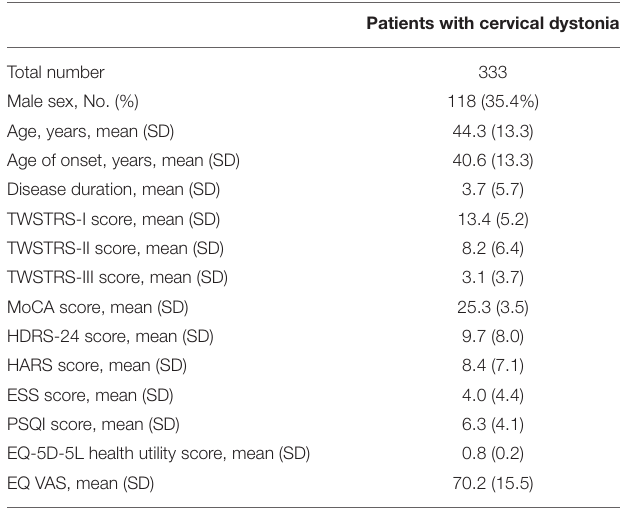
TABLE 1 | Demographic and clinical features of the recruited patients with cervical dystonia.